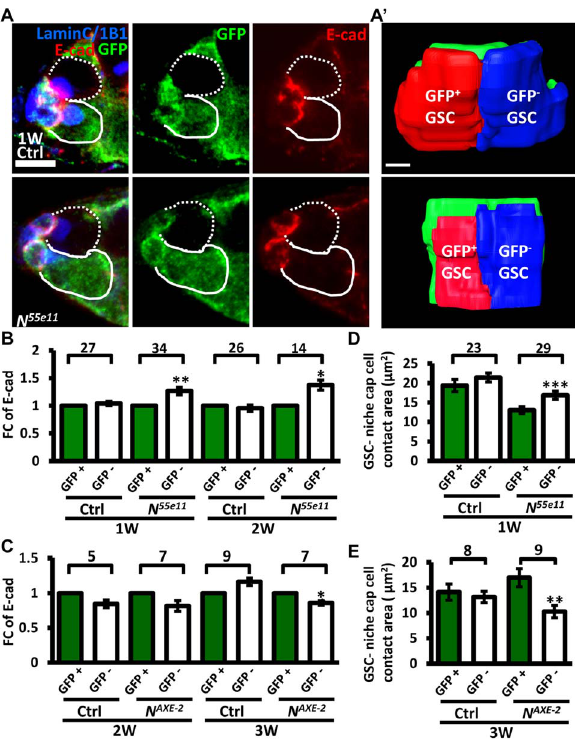
Fig. 3. Notch signaling regulates levels of E-cadherin between GSCs and the niche. (A) Mosaic germaria (one-week (w)-old control and N 55e11 mutant germaria) with GFP (green, wt cells), E-cadherin (E- cad) (red), 1B1 (blue, GSC fusomes), and LamC (blue, cap cell nuclear envelopes) labels. Wt GSCs are outlined by solid lines; control or mutant GSCs (GFP-negative ( 2 )) are outlined by dashed lines. Scale bar, 5 m m. A 9 , contact area between niche cap cells (green) and wt (red) and GFP 2 GSCs (blue). Scale bar, 1 m m. (B and C) Average fold changes (FC) of E-